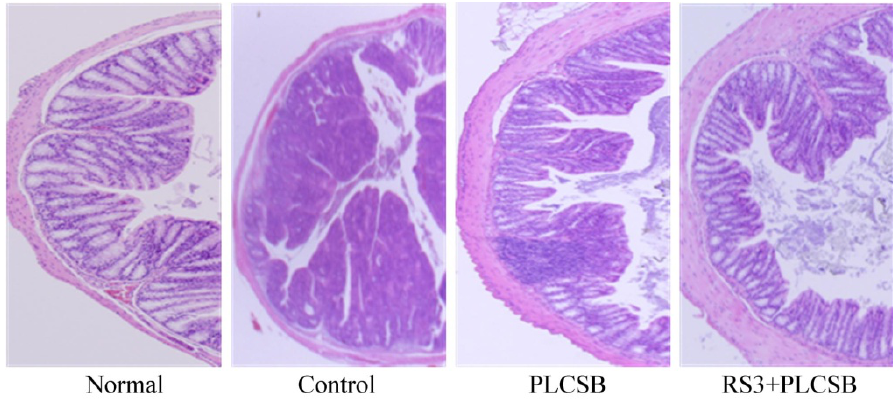
Figure 3. Microscopic observations of the effects of PLCSB and RS3 + PLCSB on histological damage in the colon tissues of mice with AOM and DSS-induced colon cancer (magnification, 40×). PLCSB, polysaccharide of Larimichthys crocea swimming bladder; RS3, resistant starch